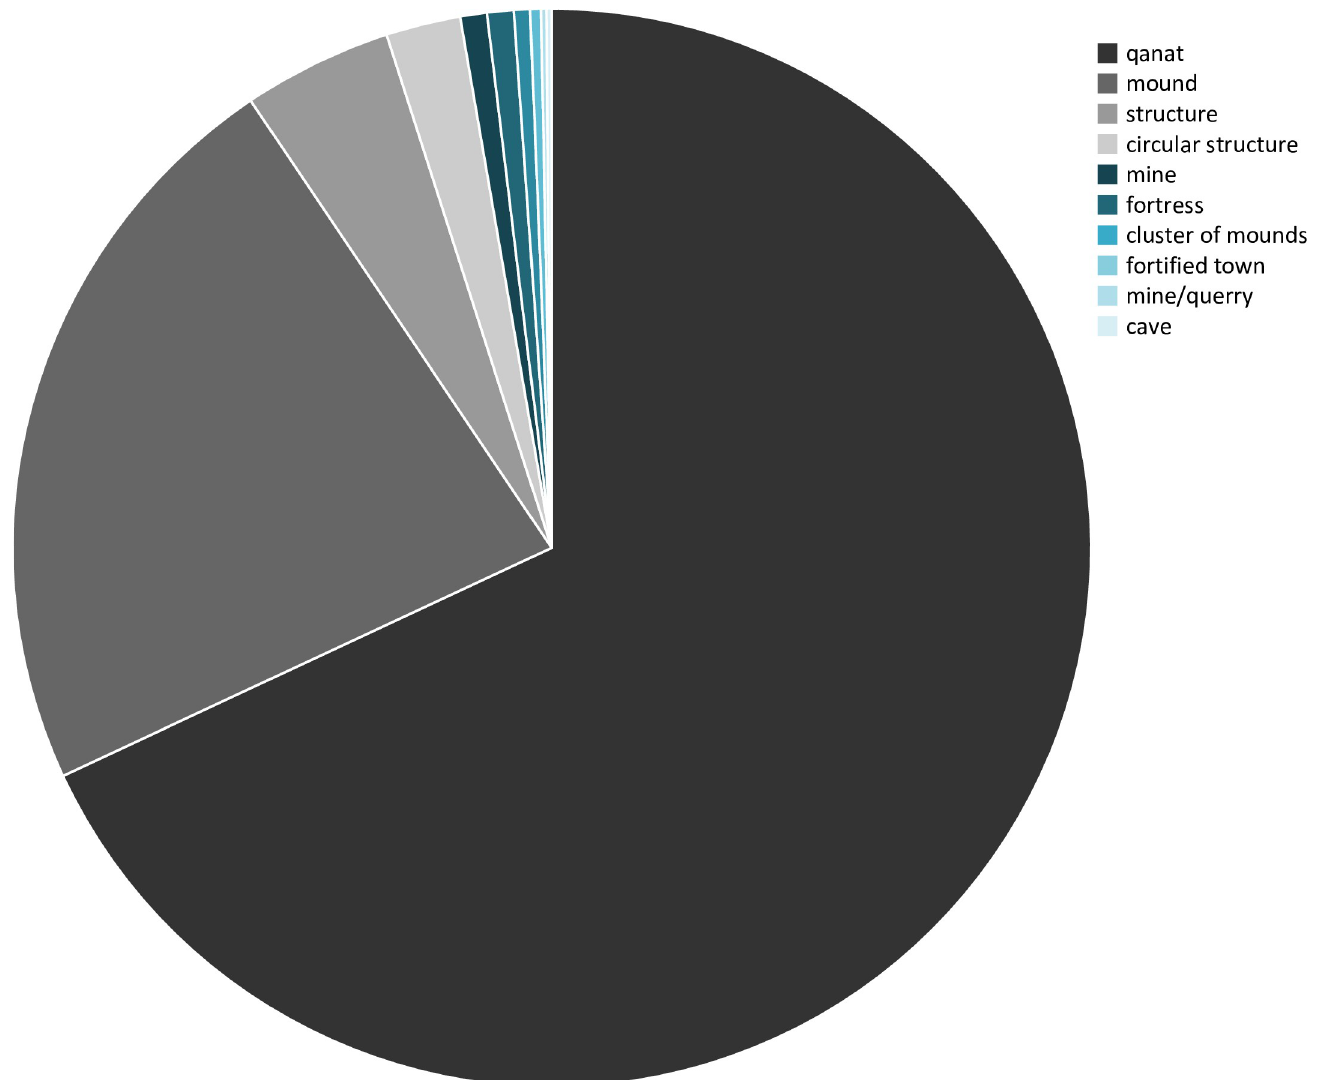
Fig 13. Pie-chart showing the ratio of